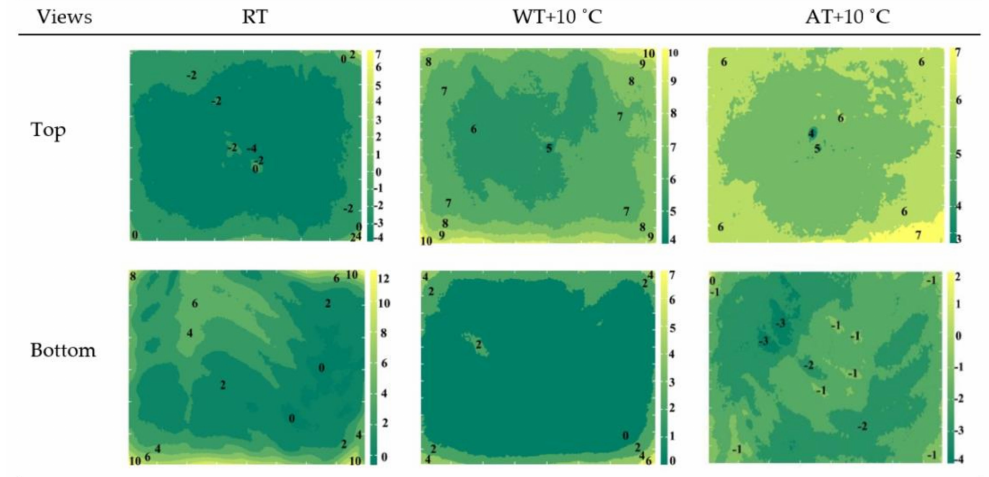
Figure 4. Surface temperature distribution of salmon fillets after different tempering treatments when the sample center reached − 4 ◦ C. (RT: Radio frequency tempering; WT + 10 ◦ C: Water tempering at 10 ± 0.5 ◦ C; AT + 10 ◦ C: Air tempering at 10 ± 1 ◦